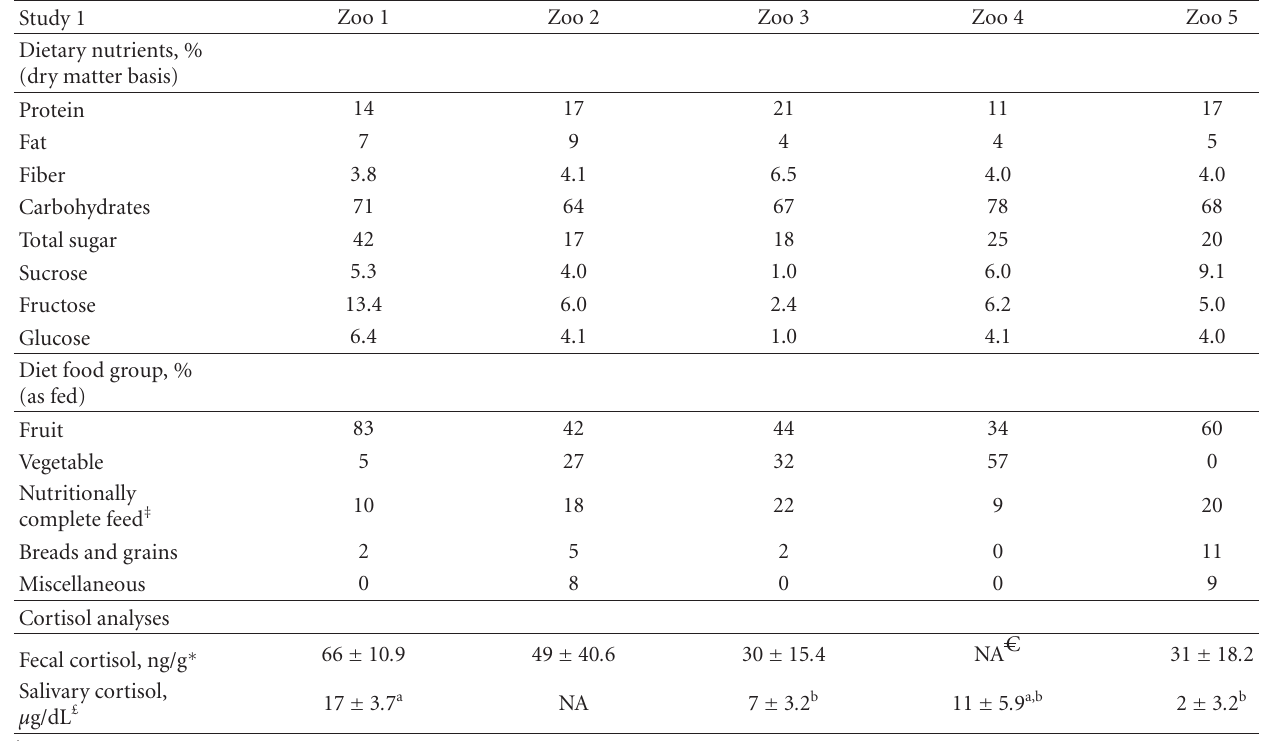
Table 2: Spider monkey diet nutrient analyses, food group percentages, and fecal and salivary cortisol concentrations ( ± SEM) from five zoological institutions in the